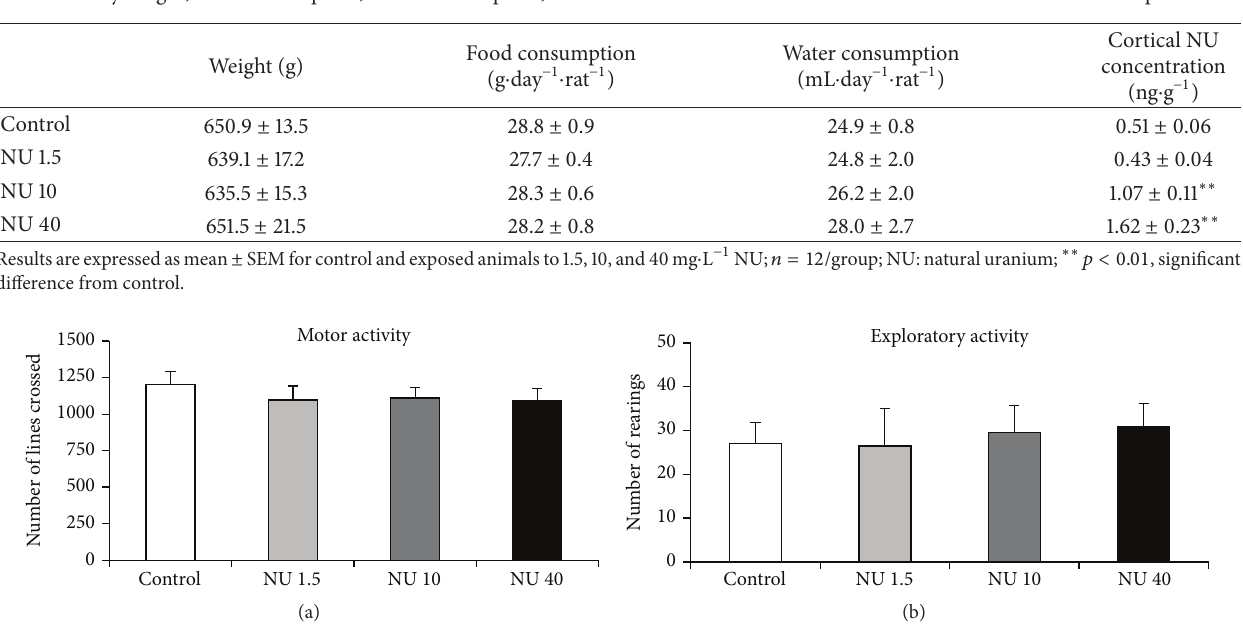
Table 1: Body weight, food consumption, water consumption, and cortical uranium concentration of male rats at the end of the experiments.